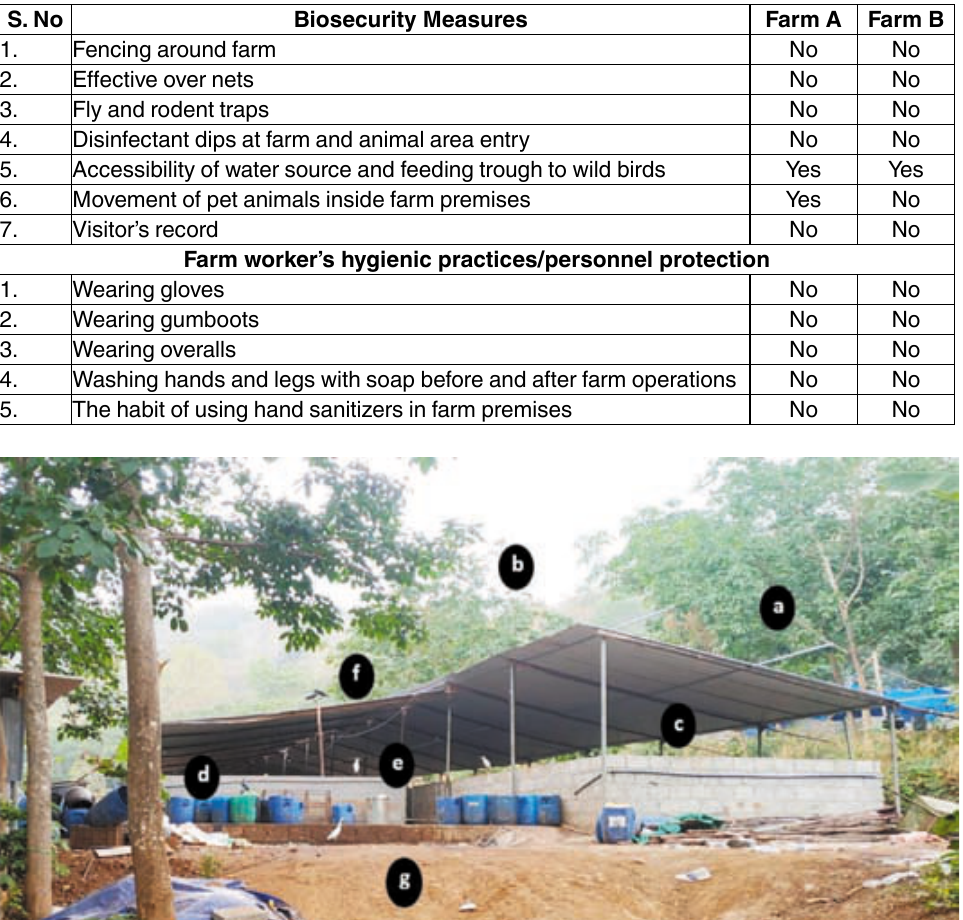
table 5. Biosecurity measures followed in pig farms